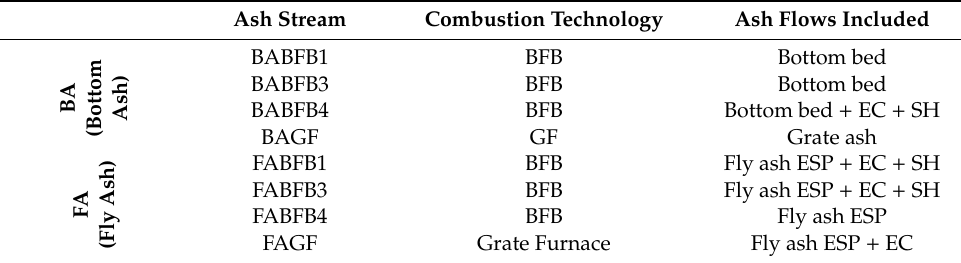
Table 3. Identification of biomass ash